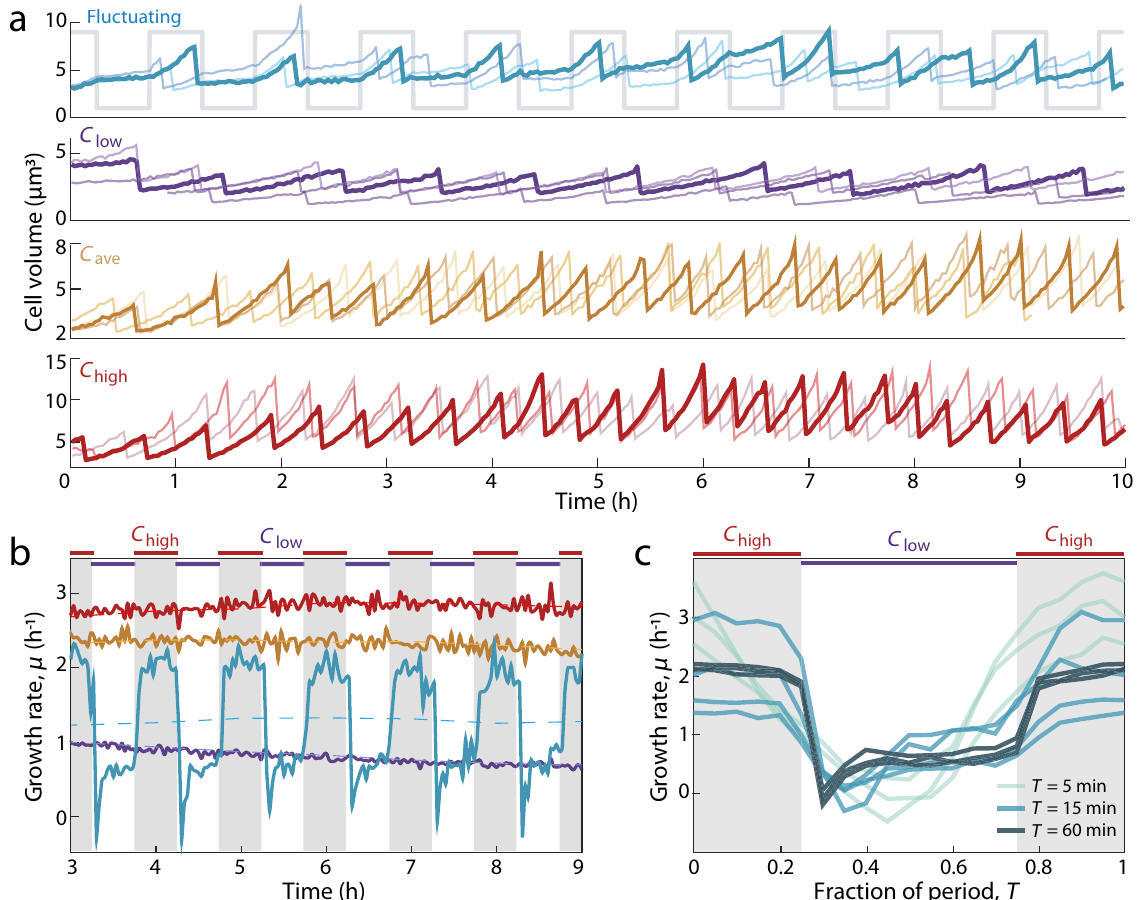
Fig. 2 Nutrient upshifts and downshifts are followed by rapid adjustments in growth rate. a Single-cell volume trajectories from a fl uctuating environment ( fl uctuation period T = 60 min) and control environments: steady C low , C ave , and C high . Each colored line tracks the repeated growth and division events of a single cell over several generations. One line is bold for clarity; the lighter lines are simultaneous tracks measured from different individuals. The gray line shows the nutrient signal in the fl uctuating environment. In the fl uctuating environment, single-cell volume grows at different rates depending on the nutrient phase. b Instantaneous growth rate, µ , over time in steady and fl uctuating environments. In the steady environments, µ is stabilized at steady-state growth by t = 3 h. In a fl uctuating environment ( T = 60 min), µ fl uctuates with the nutrient signal. Each solid curve is a time- average of all instantaneous single-cell growth rates from each 2-min time bin, based on estimates of µ from at least 1842 total cells per replicate experiment. Each dashed curve is the time-average from each 30-min time bin. Given the noise in µ at the single-cell level (see Supplementary Fig. 7), the growth rate dynamics were best visualized by averaging many cells. c Instantaneous growth rate, µ , averaged across all single-cell growth rates as a function of the nutrient phase in fl uctuating environments. Regardless of the timescale of nutrient fl uctuation ( T ), µ is higher in C high and lower in C low . Regions shaded in gray correspond to C high phases of the fl uctuating nutrient signal. Curves represent replicate fl uctuations in nutrient concentration lead to minute-scale fl uctuations in instantaneous growth rate. We next asked how these nutrient fl uctuations — and the resulting fl uctuations in instantaneous growth rate — impact the mean rate at which individual cells grow.